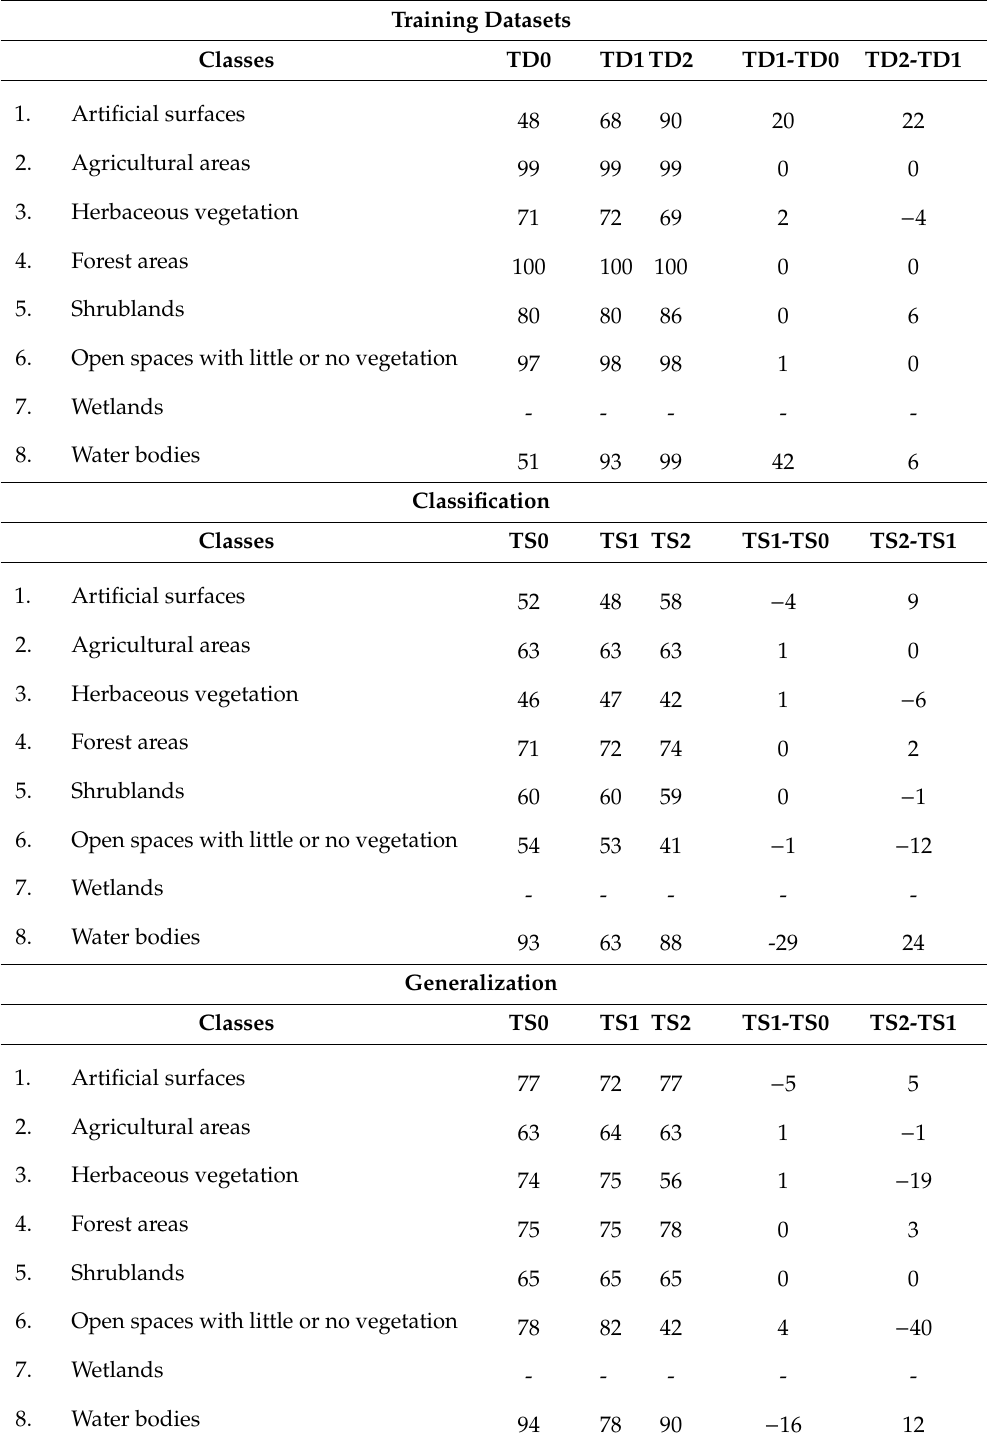
Table 11. User’s Accuracy per class (%) (equal to 100 minus the commission errors) for Study area B of the training datasets TD0, TD1 and TD2 and of the maps shown in Figure 12 resulting from the classification with TS0, TS1 and TS2. The reference data used are the maps derived from the COS 2018 with the nomenclature